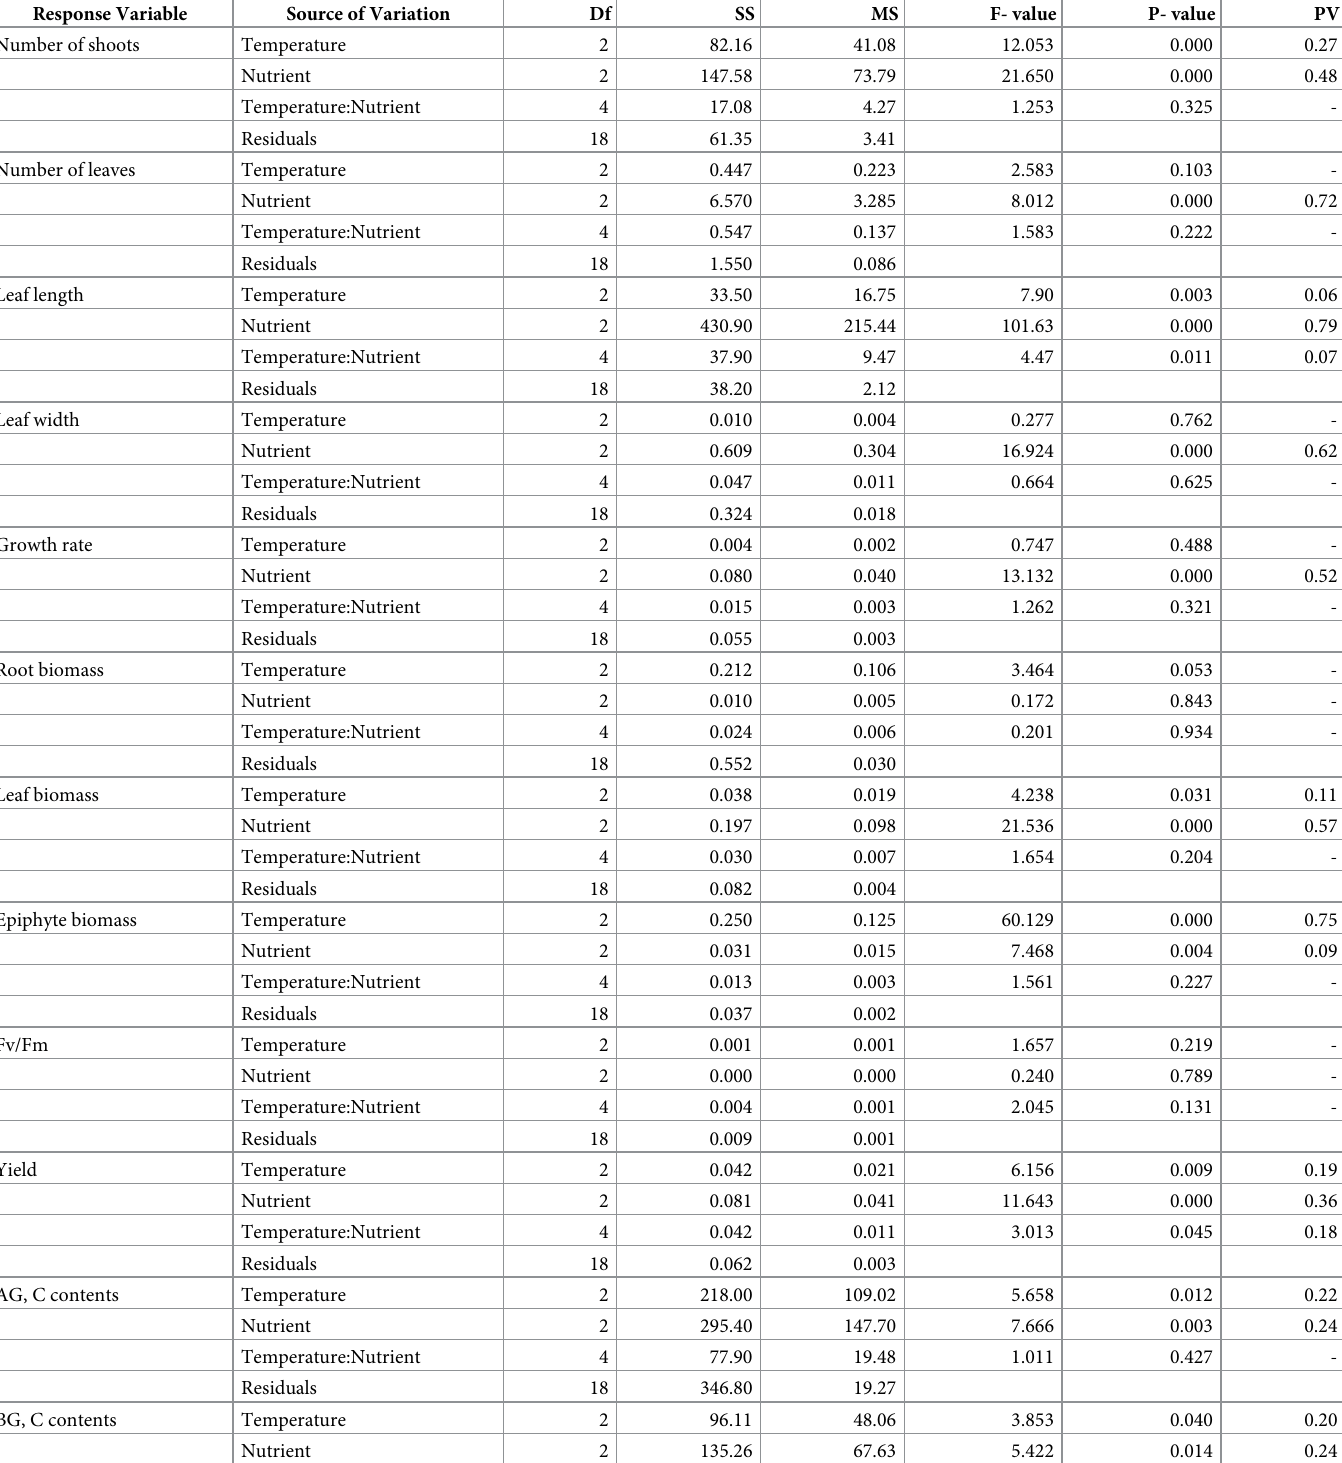
Table 1. Two-way analysis of variance (ANOVA) testing for individual and interactive effects of temperature and nutrient on Z . capensis performance. AB = Above-ground, BG = Below-ground, PV = Proportion of variance explained by a treatment (only for significant results). Response